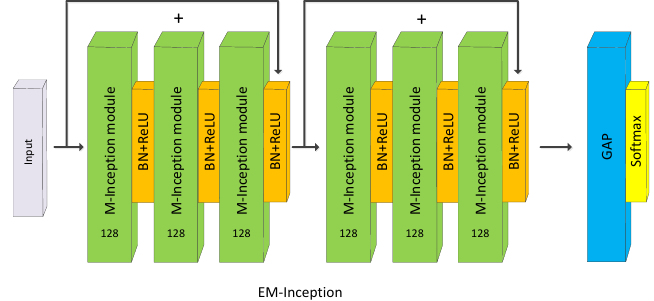
Figure 5. Architecture of EM-Inception. Each bottleneck has three basic Inception modules. Multiple paralleled convolutional operators of different kernel sizes in conjunction with a max-pooling operator are per- formed in each module in Figure 6. Like EM-ResNet, a shortcut connection is used between the consecutive bottlenecks, and the MConv layers only take the place of the convolutional layers in the residual